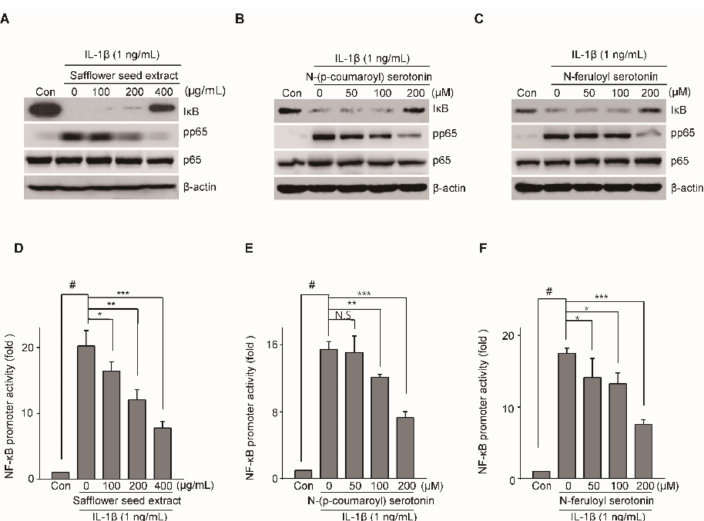
Figure 6. Safflower seed extract, N-(p-coumaroyl) serotonin, and N-feruloyl serotonin regulate IL-1 β -induced NF- κ B activation. Articular chondrocytes were pretreated with safflower seed extract, N-(p-coumaroyl) serotonin, and N-feruloyl serotonin at various concentrations for 24 h ( n = 5) before IL-1 β (1 ng/mL) treatment for 15 min. Protein expression of I κ B and pp65 was determined by western blotting ( A , B , C ; upper panel) and densitometry ( A , B , C ; lower panel). β -Actin was used as the loading control. The NF- κ B promoter activity was evaluated using the luciferase assay after treatment with safflower seed extract, N-(p-coumaroyl) serotonin, and N-feruloyl serotonin ( D , E , F ). Data are shown as mean ± SD of each group ( n = 5). # p < 0.05 compared with the control; * p < 0.05, ** p < 0.01, and *** p < 0.001 compared with the IL-1 β -treated or safflower seed extract-treated